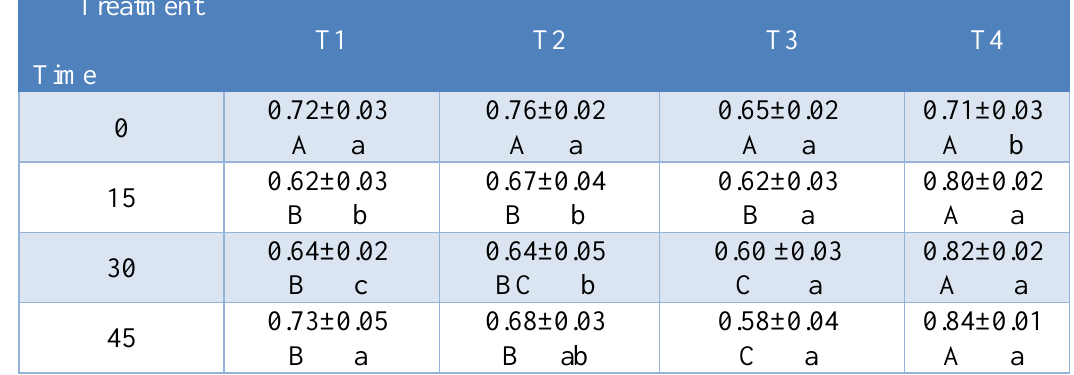
Table ,6: Effects of Salvia Officinal's (SO) and Salvia Officinal's Silver Nanoparticles (SOSNP) on serum creatinine concentration (mg/dl) in normal and methotrexate (MTX) treated rats.